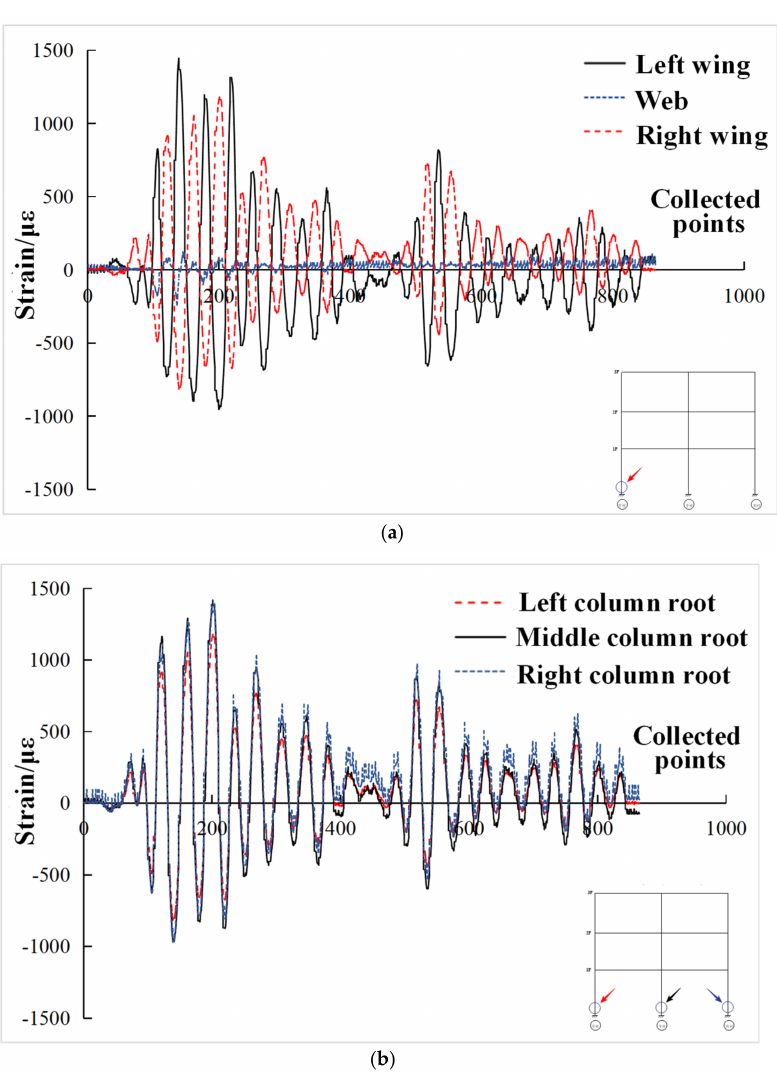
Figure 19. Strain at the root of column steel in composite frame. ( a ) Strain at the root of left steel column; ( b ) Strain at the root of each steel column.